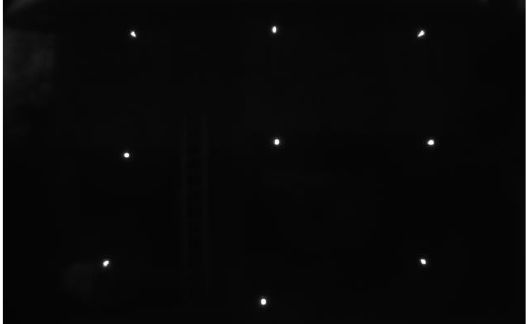
Figure 7. UV-image LED-Target-Detection used as cali-